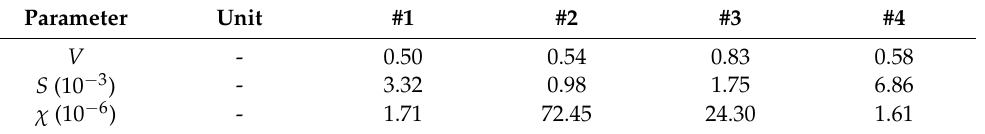
Table 3. Values of Minkowski functionals of the POEA films surfaces.